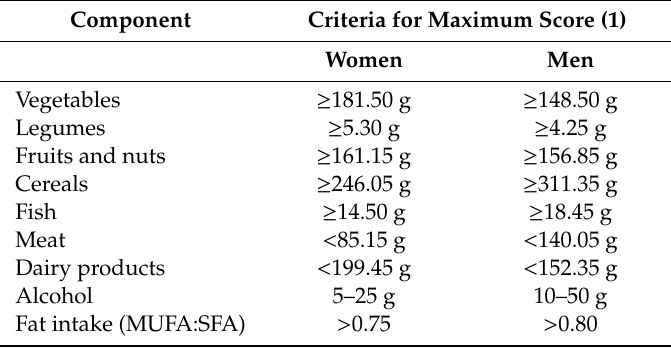
Dairy products Alcohol Fat intake (MUFA:SFA) > 0.75 >